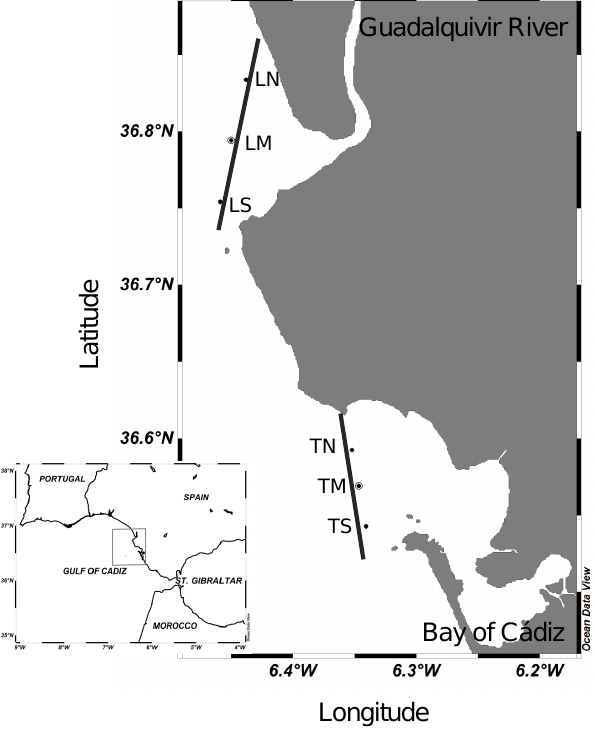
Fig. 1. Map of the north-eastern shelf of the Gulf of C´adiz showing the location of sampled stations (solid points). Lines represent tran- sects where currents and physicochemical variables were